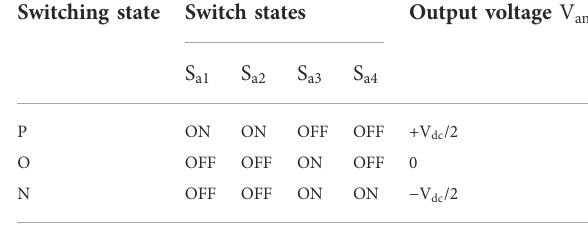
TABLE 3 Switching states Three-level diode clamped inverter (Chaturvedi et al.,